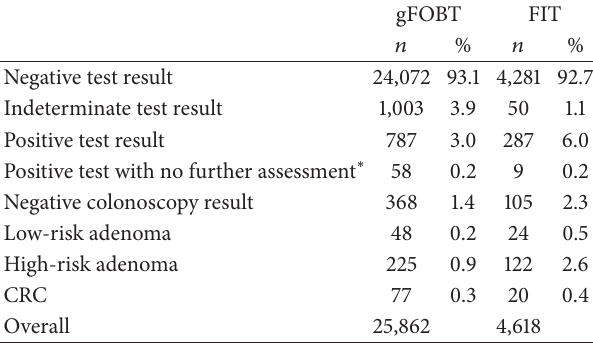
Table 1: Last screening result according to the test used (gFOBT or FIT) ‡ from 2000 to